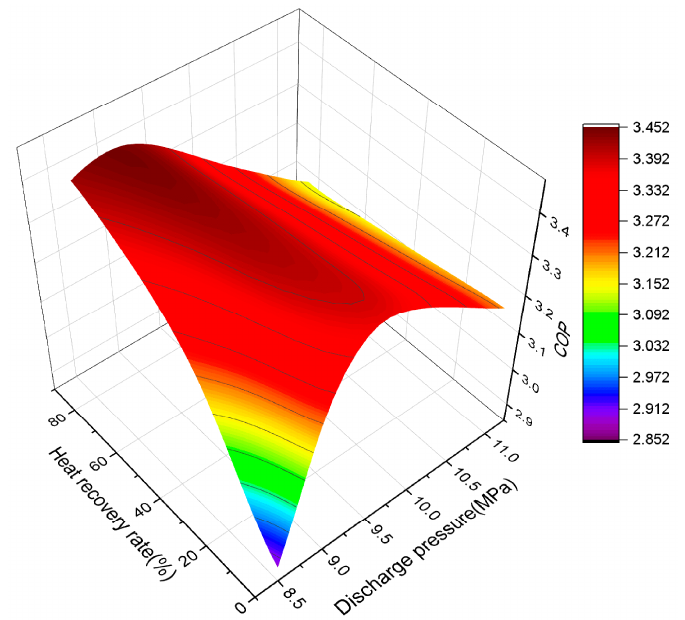
Figure 7. The collaborative optimization of the discharge pressure and heat recovery rate under 0 ° C in ambient temperature.